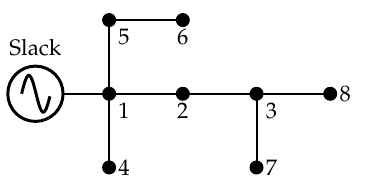
Figure 4. Single-line diagram of the 8-bus test feeder.